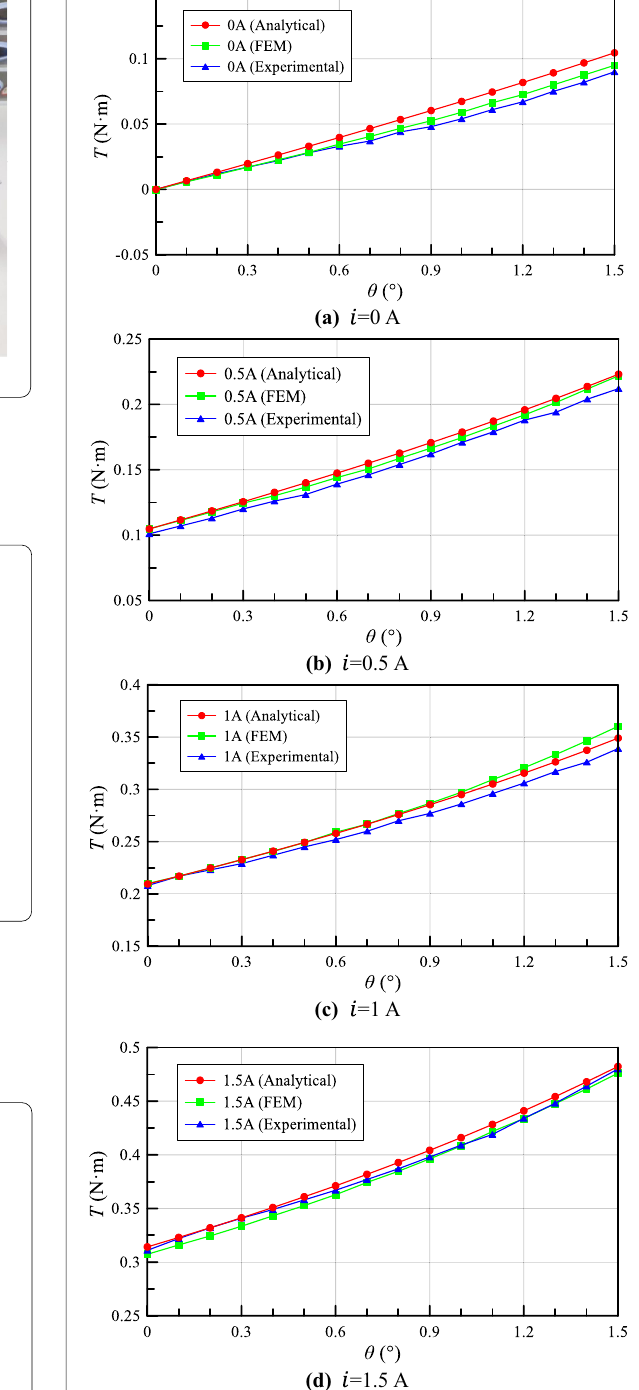
Figure 21 Torque-angle characteristics of